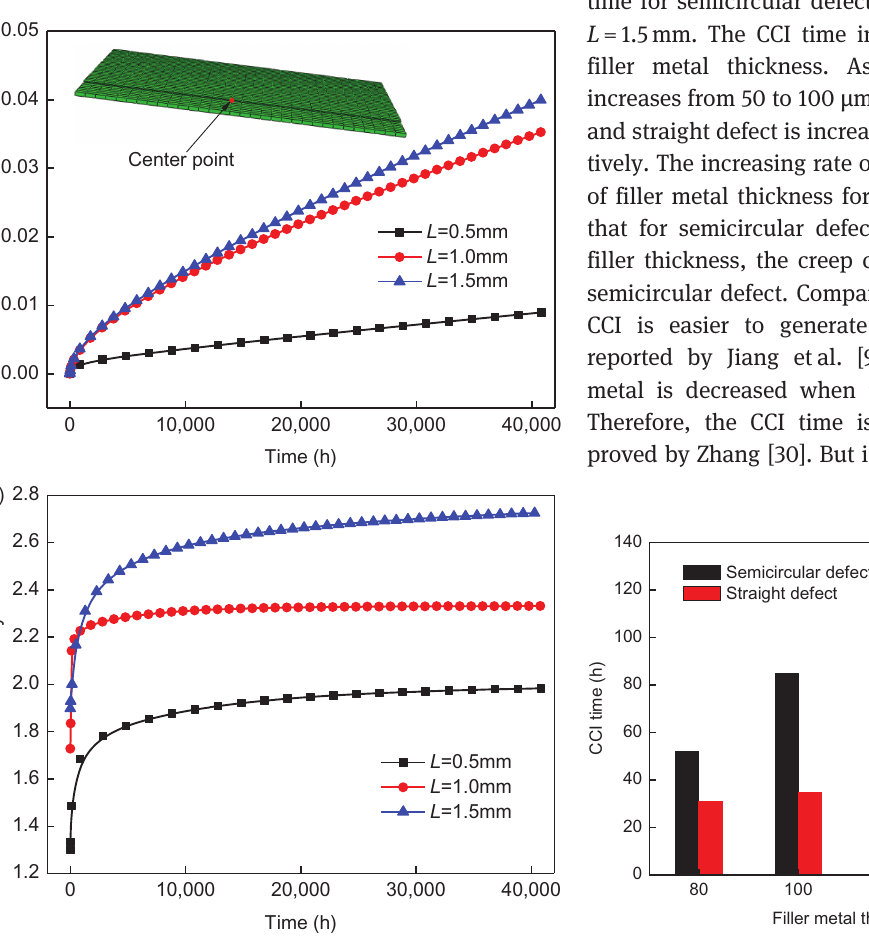
Figure 13: The effect of filler metal thickness on CCI time for different